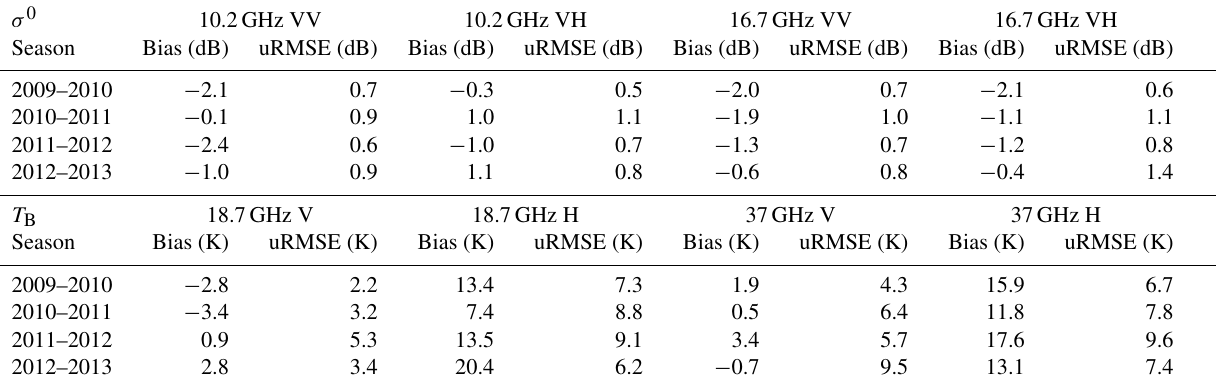
Table 5. Summary of MEMLS3&a simulation bias and unbiased RMSE for 10.2 and 16.7GHz backscattering (above) and 18.7 and 37GHz brightness temperature (below) against observations from SnowScat and SodRad instruments. Results over the dry-snow period ( T air < − 1 ◦ C) for NoSREx seasons I to IV. Simulations were optimized against T V using a seasonal scaling factor β to p ex B